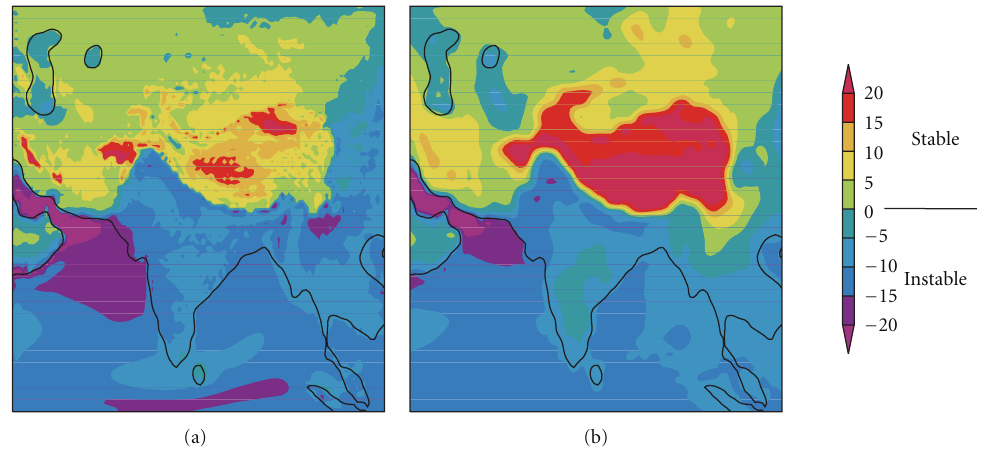
Figure 8: Potential convective instability (K) for HIRHAM (a) and ERA40 (b); summer monsoon (JJAS) 1990–2000.